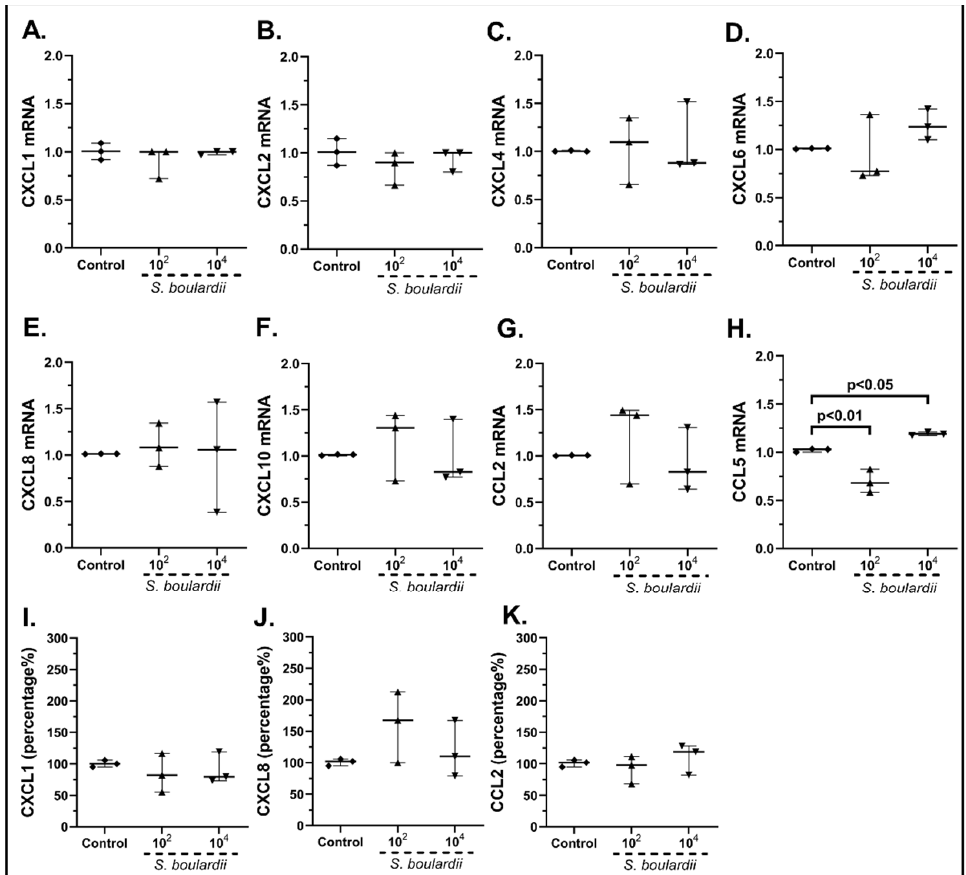
Figure 4. cSEMF mRNA expression of CXCL1 ( A ), CXCL2 ( B ), CXCL4 ( C ), CXCL6 ( D ), CXCL8 ( E ), CXCL10 ( F ), CCL2 ( G ) and CCL5 ( H ) and protein levels of CXCL1 ( I ), CXCL8 ( J ) and CCL2 ( K ) after stimulation with Saccharomyces boulardii. Results are presented as median with interquartile range. N = 3.